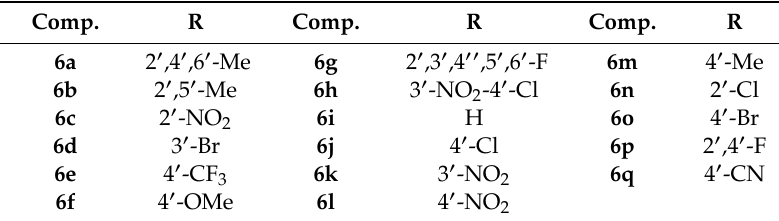
Table 1. The R groups of the compounds 6a – 6q .